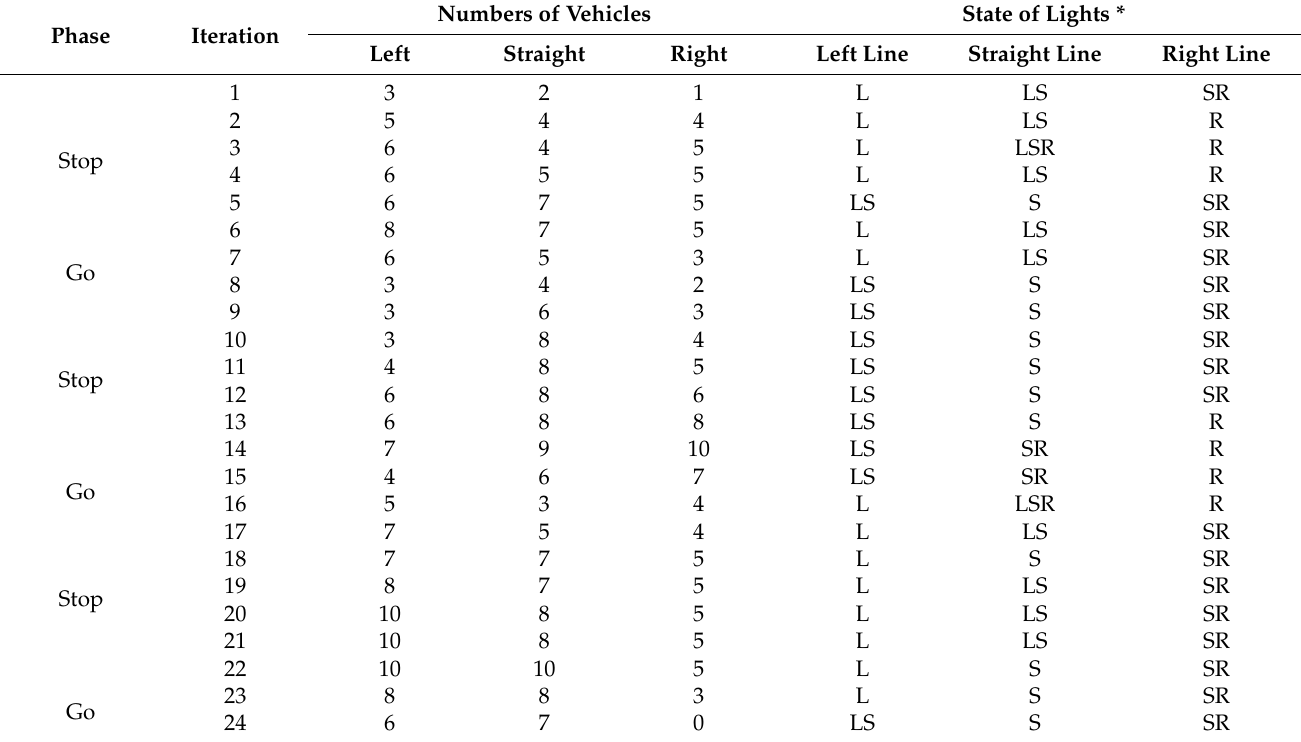
Table 1. An exemplary distribution of vehicles with a declared driving direction. Phase